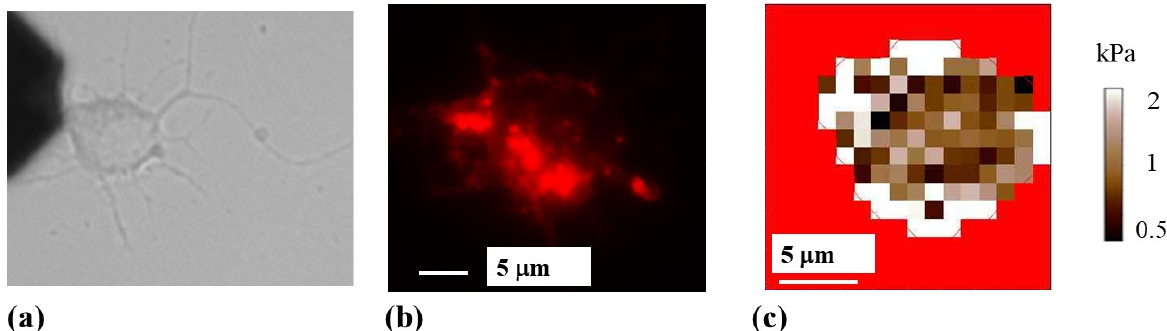
Figure 5. ( a ) Bright-field optical image of a neuron. The AFM cantilever appears on the left side of the image; ( b ) fluorescence image of the same neuron stained for actin. Regions of high actin density correspond to the bright red areas; ( c ) elasticity map for the cell shown in ( a , b ). The elasticity map was acquired with a cantilever with spring constant of 2.8 N/m. The cell body regions that display higher-than-average values of the elastic modulus correlate with regions with high concentration of actin. The location of regions with high actin concentration does not change significantly during the AFM measurements.